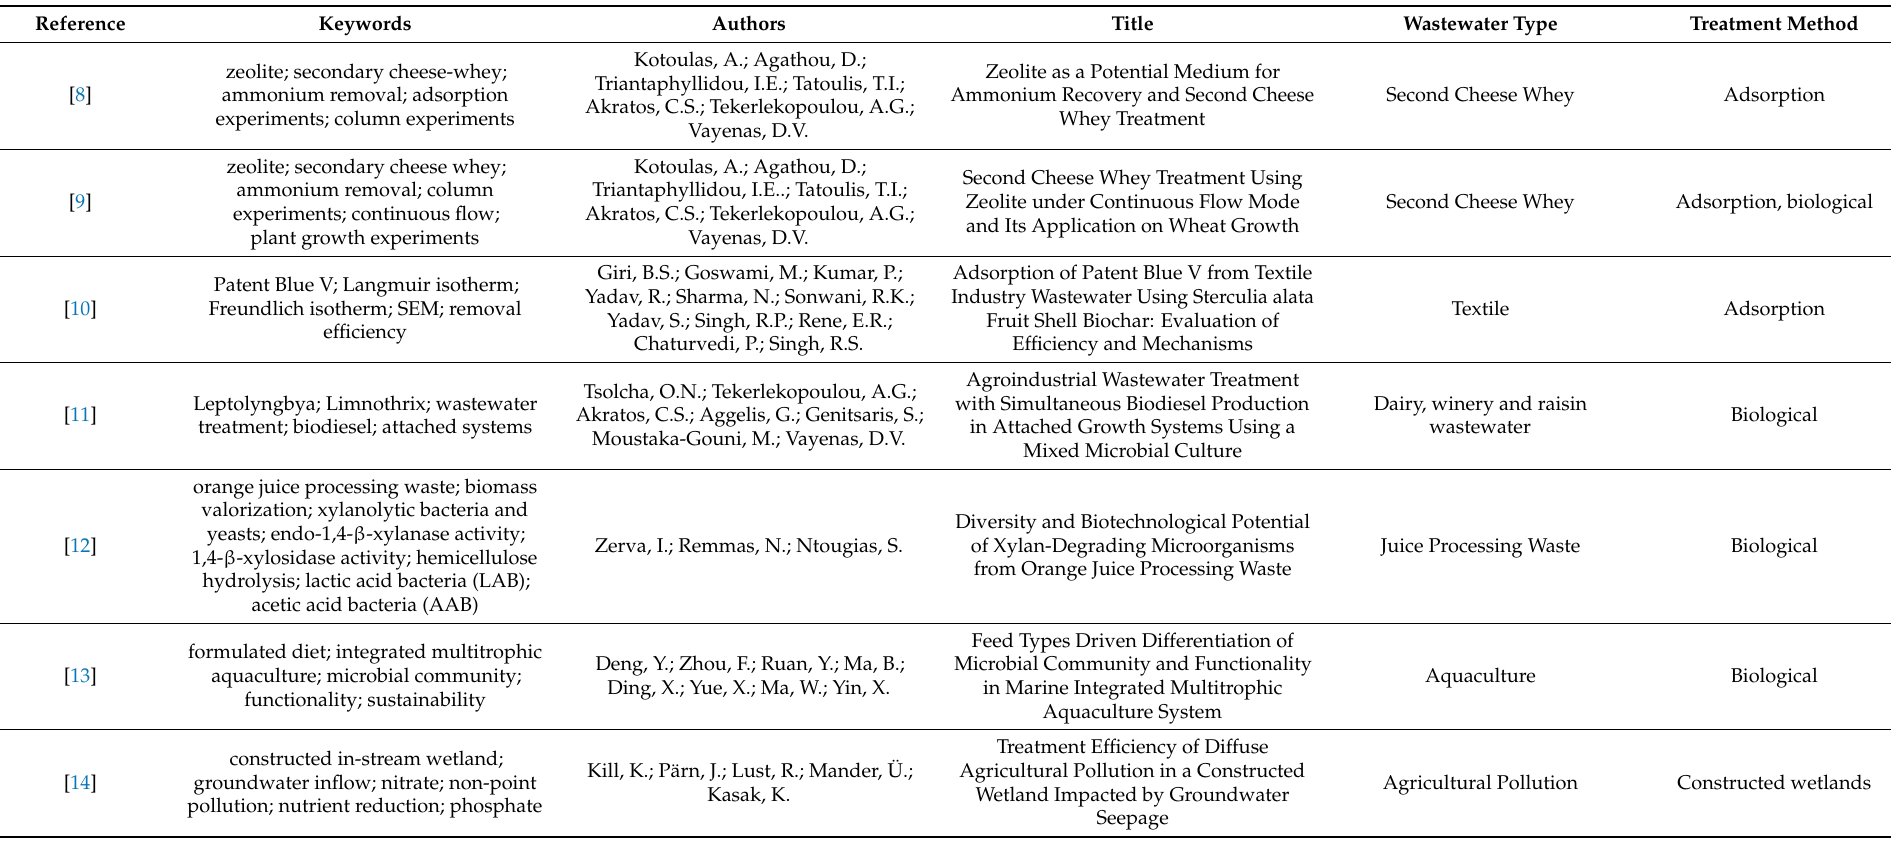
Table 1. Summary of the seven papers published in the Special Issue “Agro-Industrial Wastewater Treatment with Decentralized Biological Treatment Methods” in the Water Journal (https://www.mdpi.com/journal/water/special_issues/water_agro-industrial_wastewater_decentralized_biological_treatment, accessed on 8 March